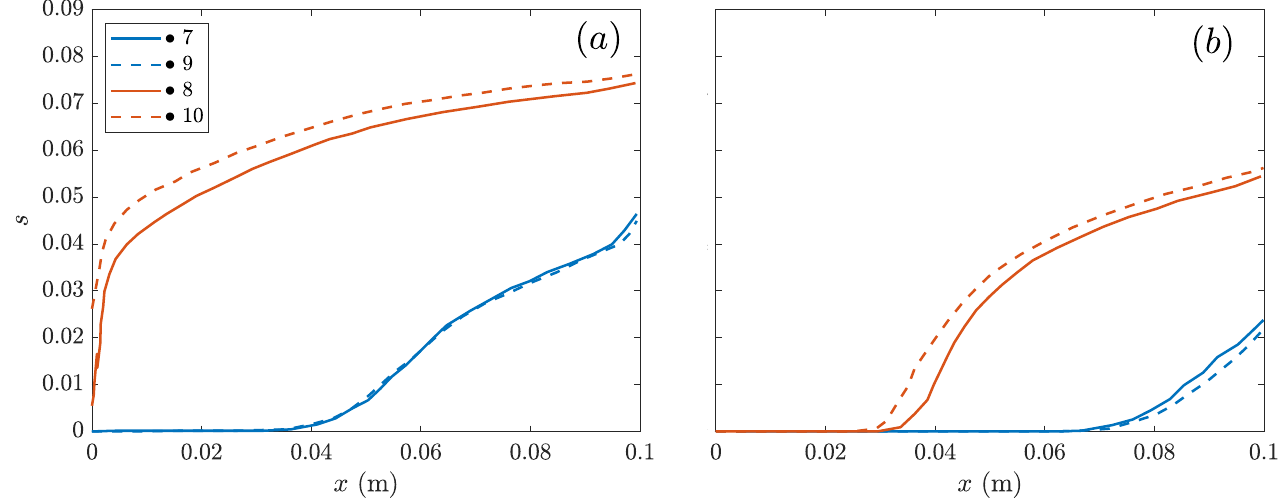
Figure 7. SIGRACET 34BC without MPL cathode liquid saturation along the x -coordinate: ( a ) low voltage 0.45 V, ( b ) medium voltage 0.65 V.